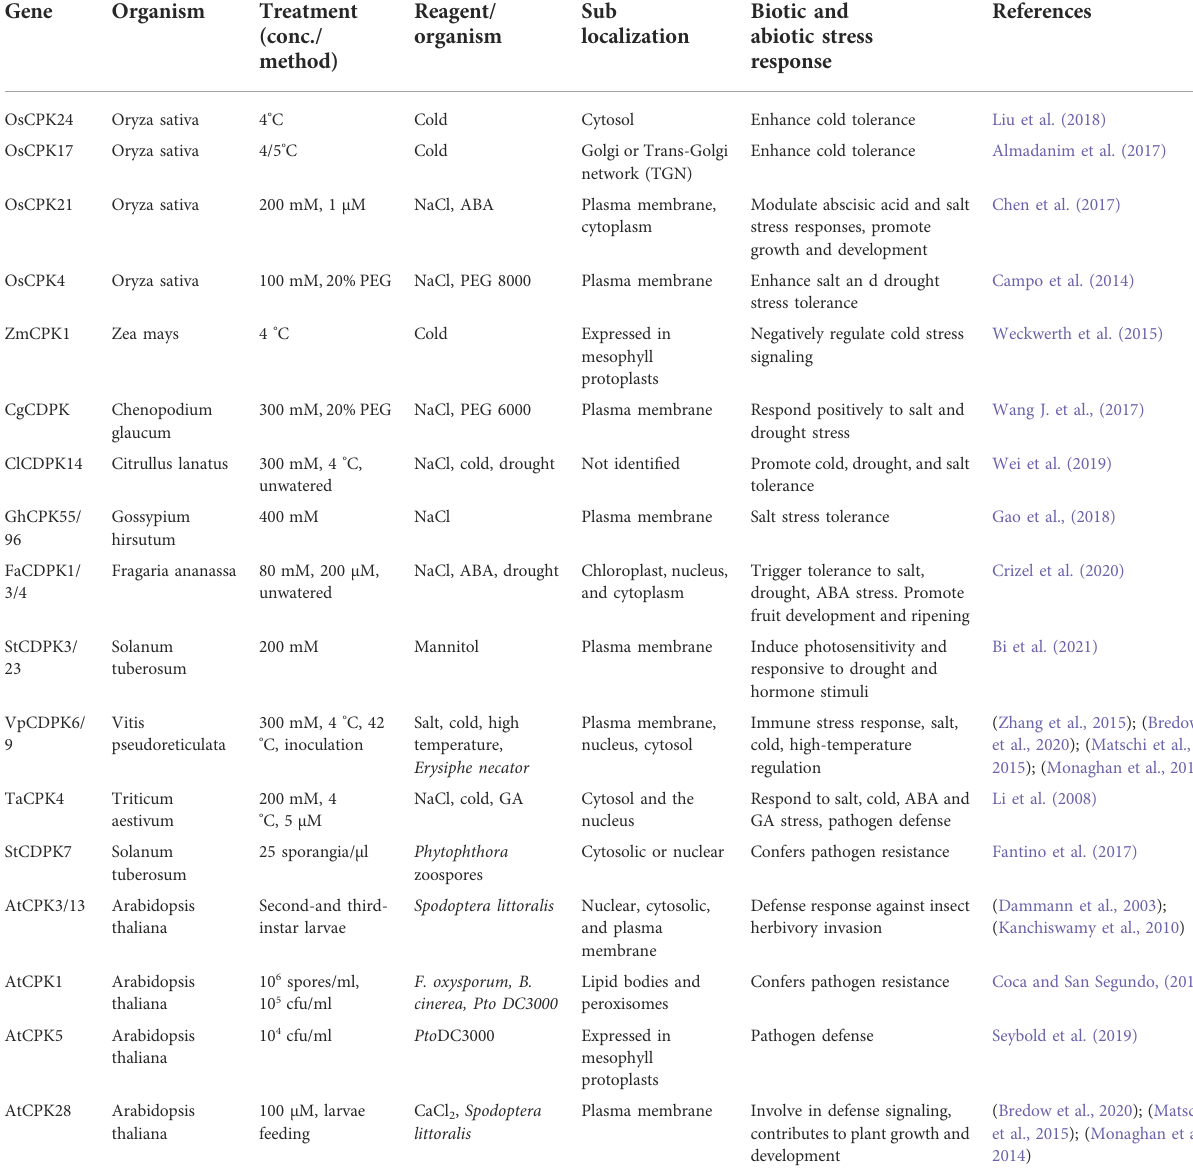
TABLE 2 Physiological role of CDPKs in plants and their subcellular location under biotic and abiotic